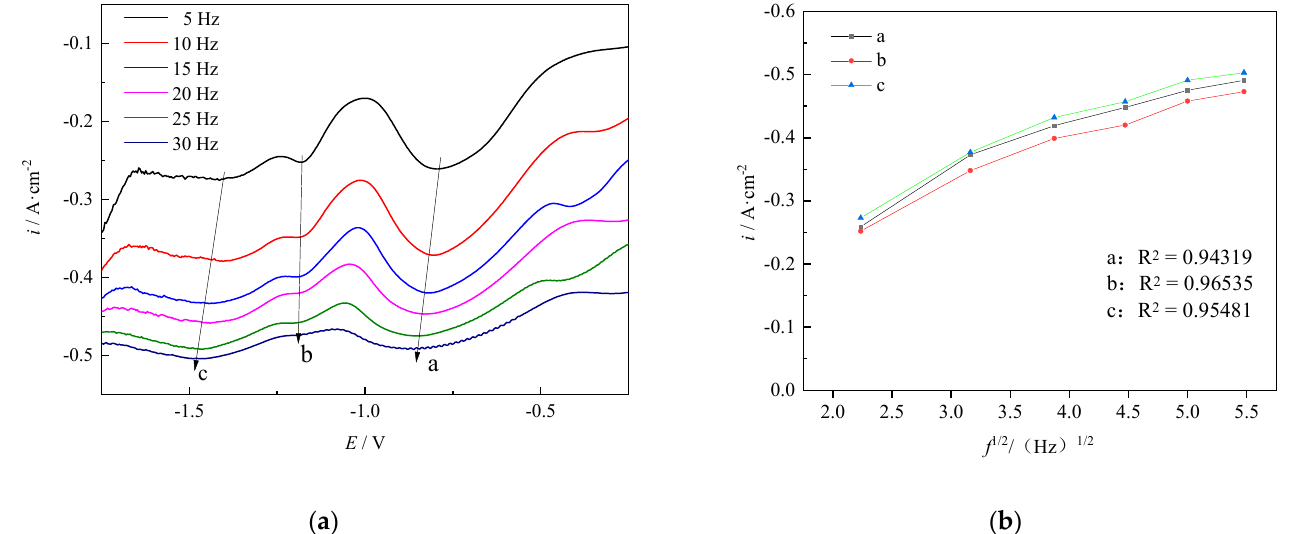
Figure 3. ( a ) Square wave voltammetry curve on Pt electrode surface in NaCl–CaCl 2 –LiMn 2 O 4 ; ( b ) Relationship between f 1/2 and i pc in NaCl–CaCl 2 –LiMn 2 O 4 on Pt electrode.